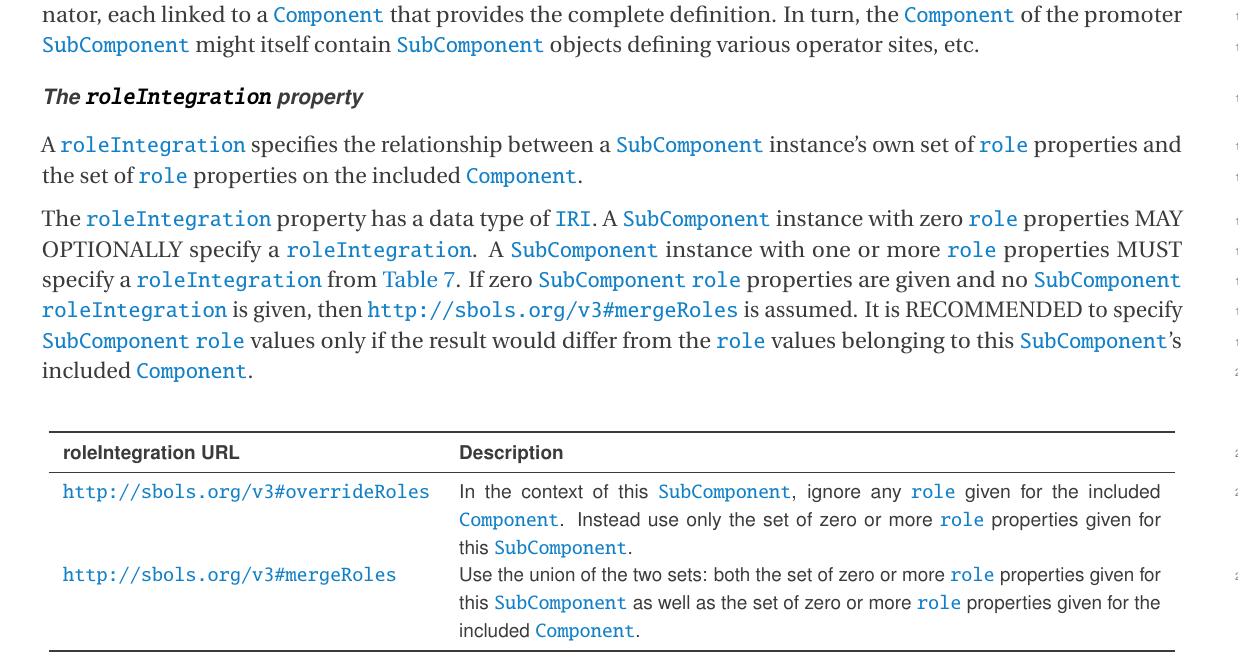
Table 7: Each roleIntegration mode is associated with a rule governing how a SubComponent ’s role values are to be combined with the included Component ’s role